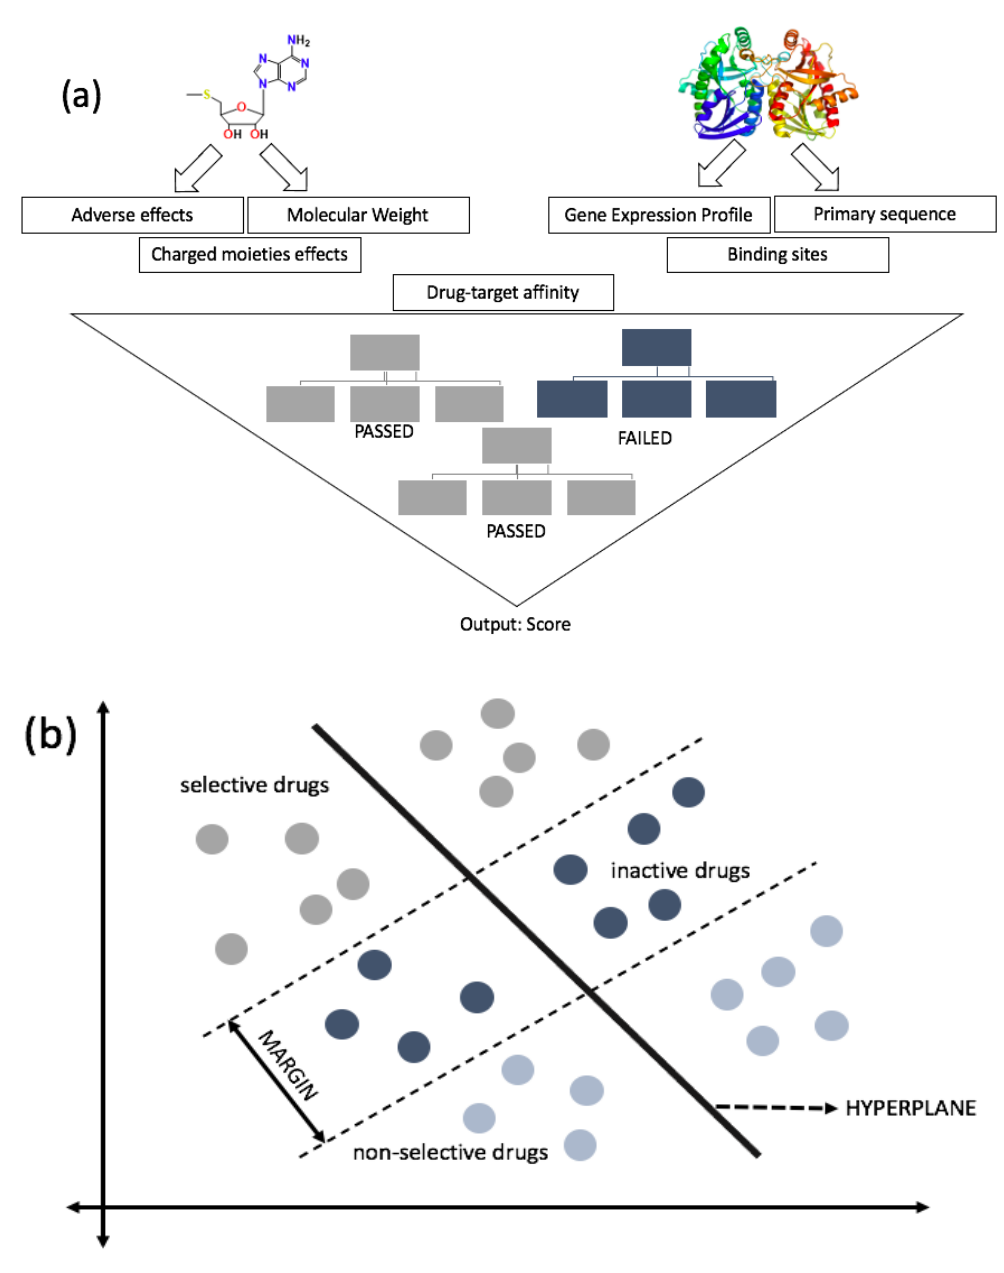
Figure 2. Schematic view of drug development using random forest (RF) ( a ) and support vector machine (SVM) ( b ). ( a ) RF reaches the final decision of drugs by combining the results of randomly-